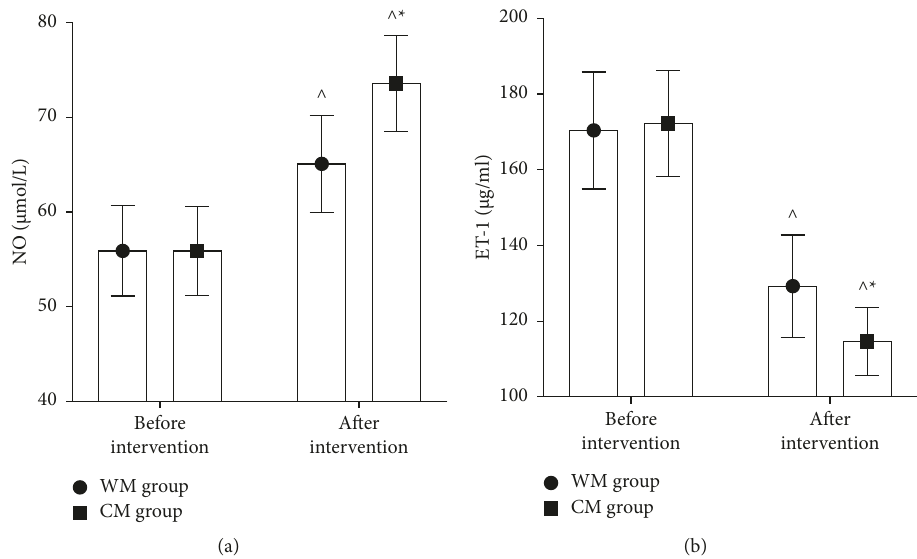
Figure 3: Comparison of NO and ET-1 levels in both groups. (a) NO levels. (b) ET-1 levels. Compared with the same group before intervention,